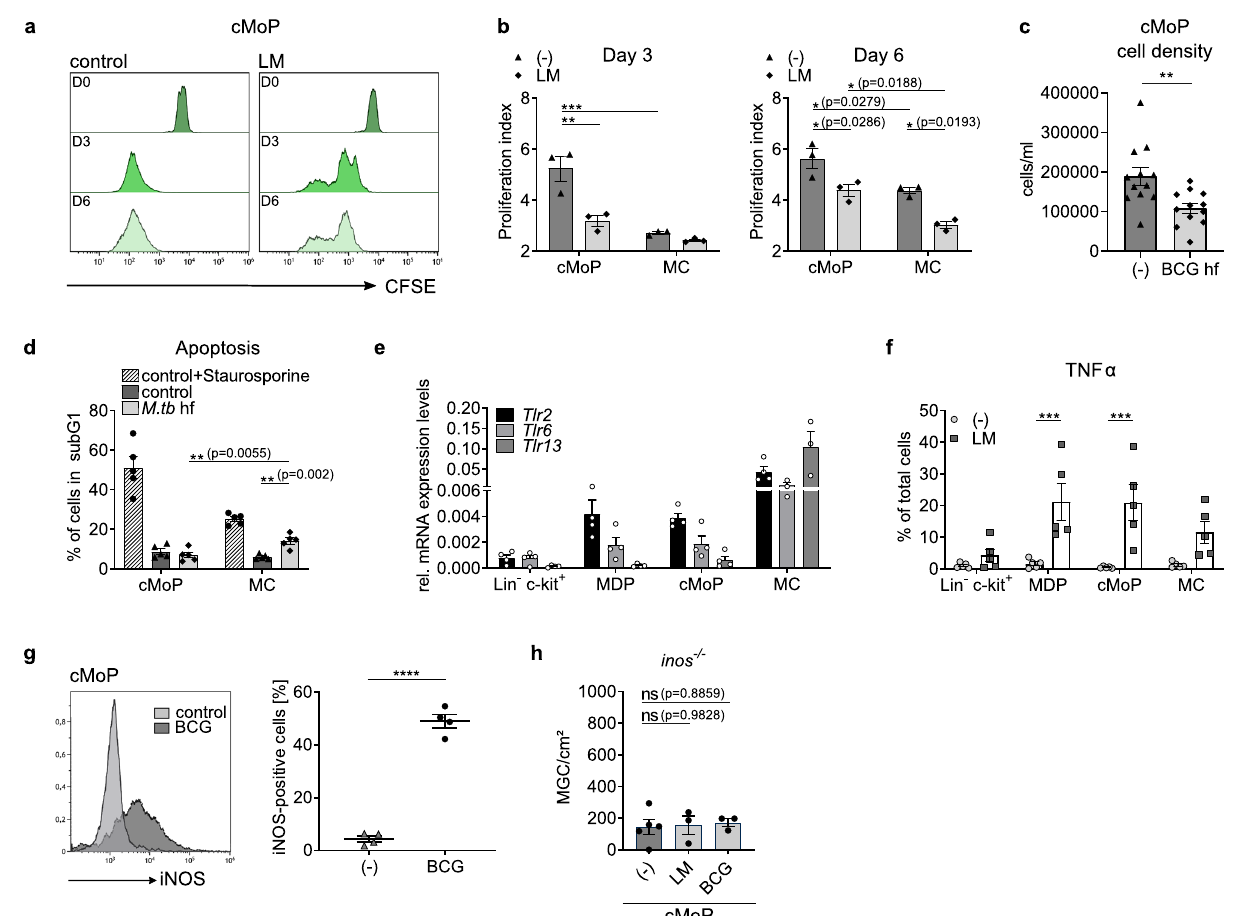
Fig. 2 cMoP combine macrophage and progenitor characteristics. a cMoP from WT mice were stained with CFSE and stimulated with lipomannan from M. smegmatis (LM, 4 µ g/ml), followed by FACS analysis after 5 h (D0, dark green), 3 days (D3, green) and 6 days (D6, light green). b Proliferation index based on CFSE staining (Fig. 2a) was determined as PI ¼ ∑